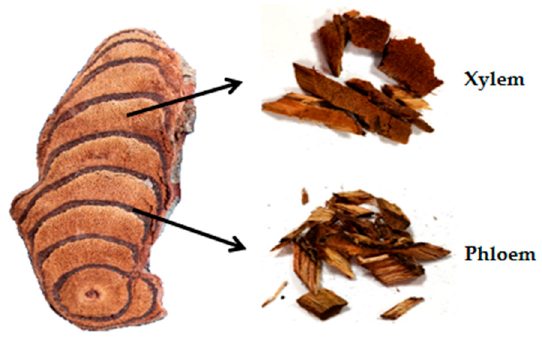
Figure 7. The xylem and phloem of Spatholobi Caulis.